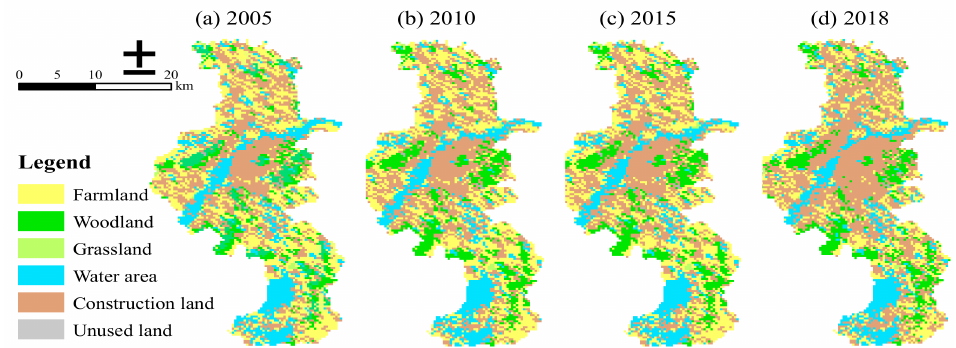
Figure 2. Land-use classification of Nanjing in ( a ) 2005, ( b ) 2010, ( c ) 2015, and ( d )